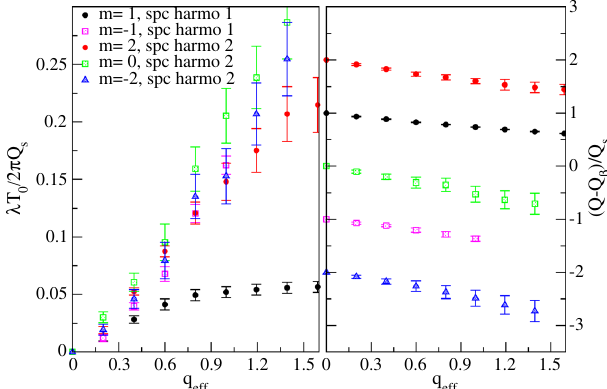
FIG. 8. 3D-G bunch. The Landau damping (a) and the relative tune shift (b) versus the space charge parameter q in the weak eff space charge regime for a few modes. The modes m ¼ − 1 ; 1 in the figure are excited with a shape proportional to the first space charge harmonic while the modes m ¼ − 2 ; 0 ; 2 are excited with a shape proportional to the second space charge harmonic. m ¼ 0 . Only the modes corresponds to the angular number at q eff which have a large overlap with the excitation shapes are shown. The modes which transform into the space charge modes with increasing q (black and red) are least damped. eff